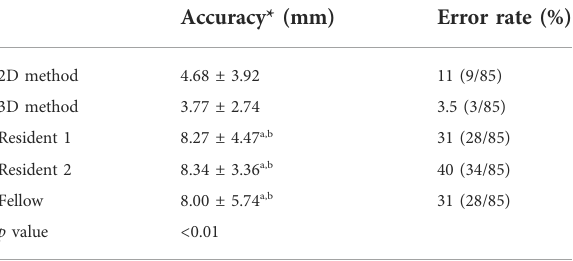
TABLE 2 Accuracy and error rateof clinical residents, musculoskeletal radiology fellow, 2D CNNs, and 3D CNNs in localization of ACL ruptures.